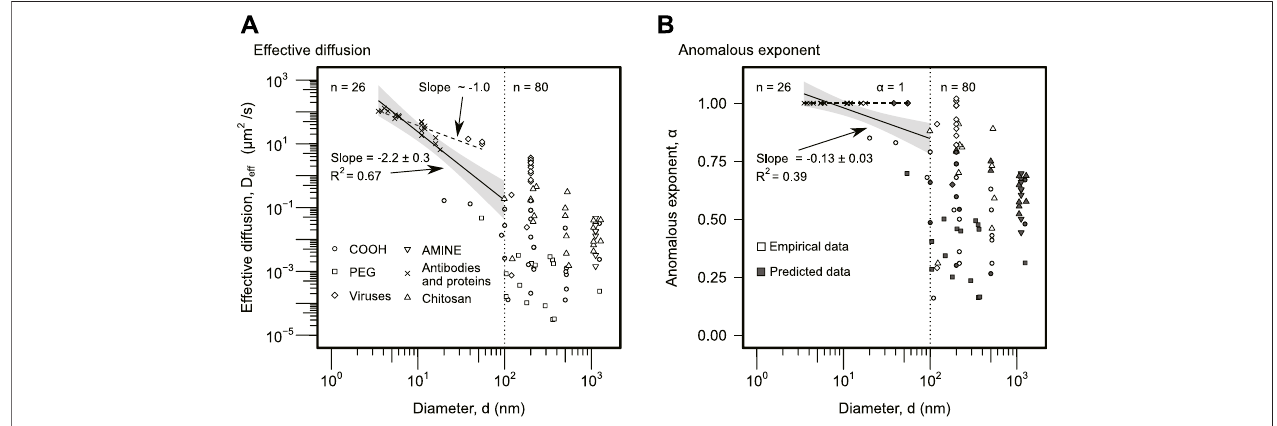
FIGURE 3 | Particle size analysis. (A) The effective diffusion was plotted against particle size, d. The different symbols correspond to different particle types as indicated in the legend. The solid line indicates the linear regression for d < 100 nm particles using log – log data (n (cid:1) 26), and it displays the slope and coef fi cient of determination, R 2 . The gray area represents the 95 % con fi dence interval. The group of particles with d > 100 nm ( n (cid:1) 80) did not display a statistically signi fi cant relationship,andnosolidlineisincluded.Thedashedlinecorrespondstothelinearregressionofthesubsetofparticles(n (cid:1) 21)displayingregulardiffusion, α (cid:1) 1,in Figure 2B , using the log – log data. The slope was approximately 1 as expected ( slope (cid:1) − 1.0 ± 0.1, p -value (cid:1) 1.4 · 10 – 7 , R 2 (cid:1) 0.77). (B) The anomalous exponent was plottedasafunctionoftheparticlesize.Thesymbolsandlinesareanalogoustopanel (A) .Asinpanel (A) ,thesolidlineistheregressionfortheparticleswith d < 100(n (cid:1) 26),whilethedashedlinerepresentsthesubset(n (cid:1) 21)predictedtodisplayregulardiffusion, α (cid:1) 1.Emptysymbolsanomalousexponentsobtainedempirically.Thesolid symbols correspond to the predicted anomalous exponents for the subset of data that did not include empirical values. The predictions were obtained using the model derived from Figure 2B .